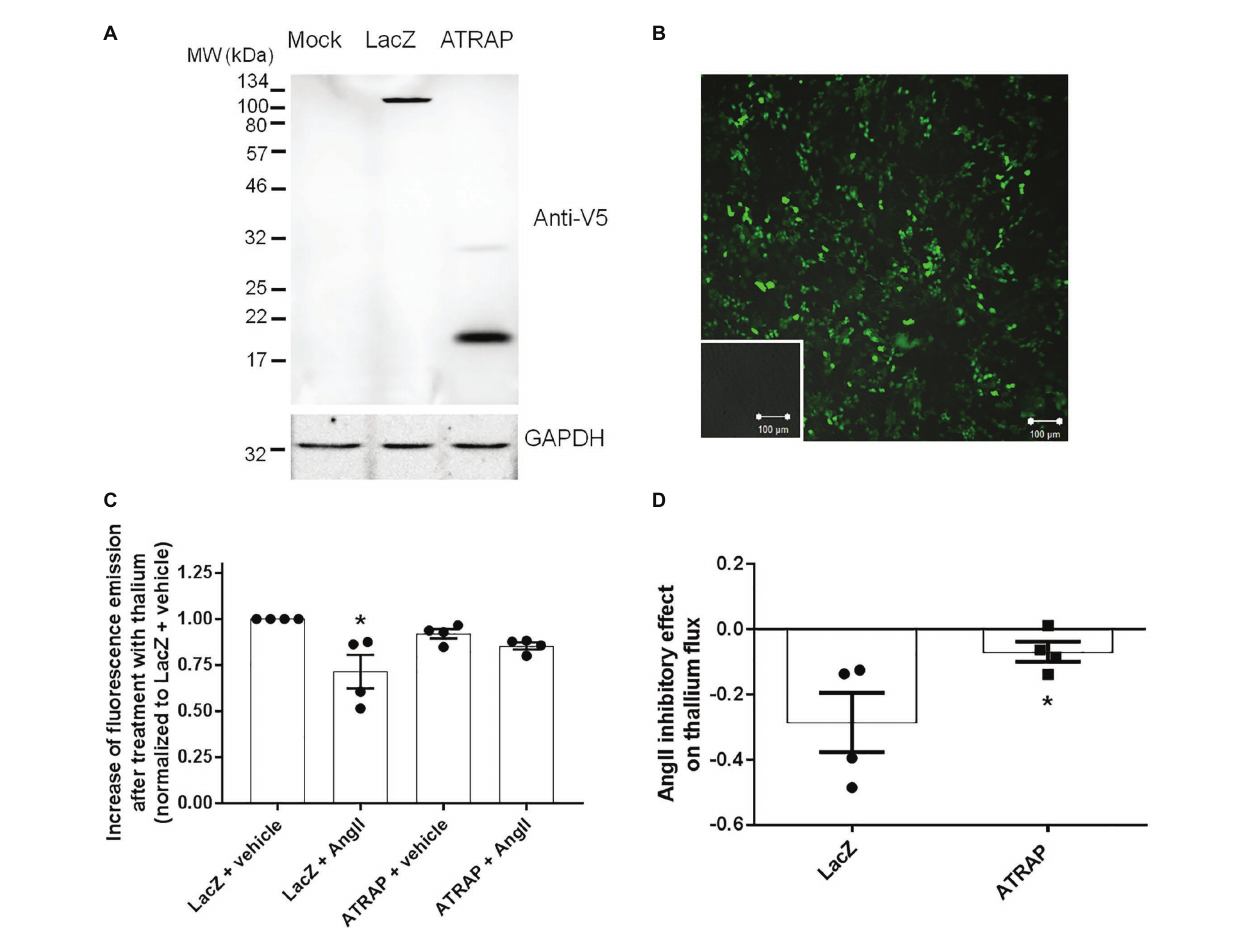
FIGURE 3 | Angiotensin II type 1 receptor-associated protein (ATRAP)-overexpression attenuates Ang II-mediated ROMK inhibition in M-1 cells. (A) Representative immunoblot of M-1 cells transfected with galactosidase (LacZ-V5) and ATRAP-V5 vectors probed with an anti-V5 antibody. (B) Evaluation of lipotransfection protocol efficiency in M-1 cells that were transfected with a GFP-encoding vector. Green fluorescence emission in M-1 cells was detected using a 505–550 nm filter in a confocal microscope after exciting GFP-transfected and mock-transfected M-1 cells at 488 nm laser light. Images were captured at 10x magnification.